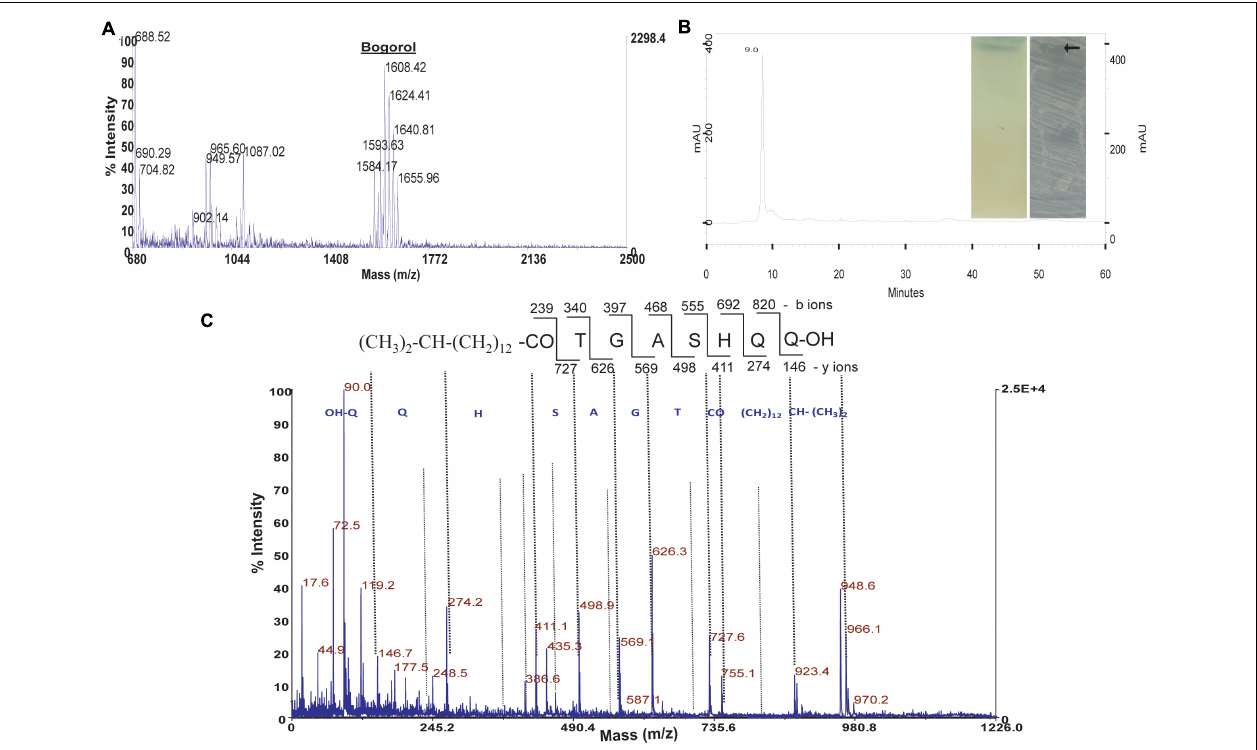
FIGURE 1 | Purification and characterization of antimicrobial compound from strain GI9. (A) MALDI of crude extract from strain GI9 showing secretion of different compounds. (B) HPLC chromatogram of purified antimicrobial peptide at retention time 9 min. Inset shows phosphomolybdic acid stained TLC of pure compound and bioautogram with inhibition zone against S. aureus MTCC 1430. (C) MS/MS fragmentation pattern of iturin-like lipopeptide (ILL) at m/z 966.1 Da.